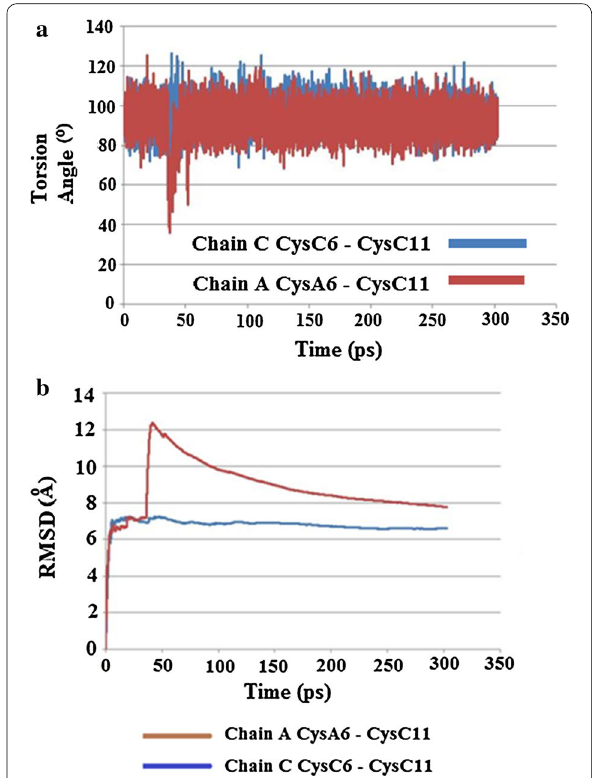
Fig. 25 a Plot of torsion angle χ3 changes for Cys6–Cys11 in chains A and C in HR insulin Intergen (II) 3W7Y for the MD simulation carried out at 320 K. b Plot of RMSD kinetics of Cys6–Cys11 torsion angles χ3 for the HR insulin Intergen (II) 3W7Y in chains A and C, respectively. MD simulations carried out at 320 K